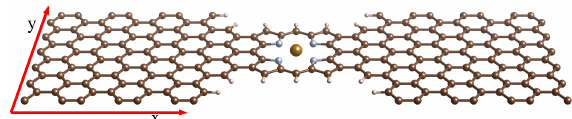
Figure 1. Fe porphyrin molecule contacted to graphene